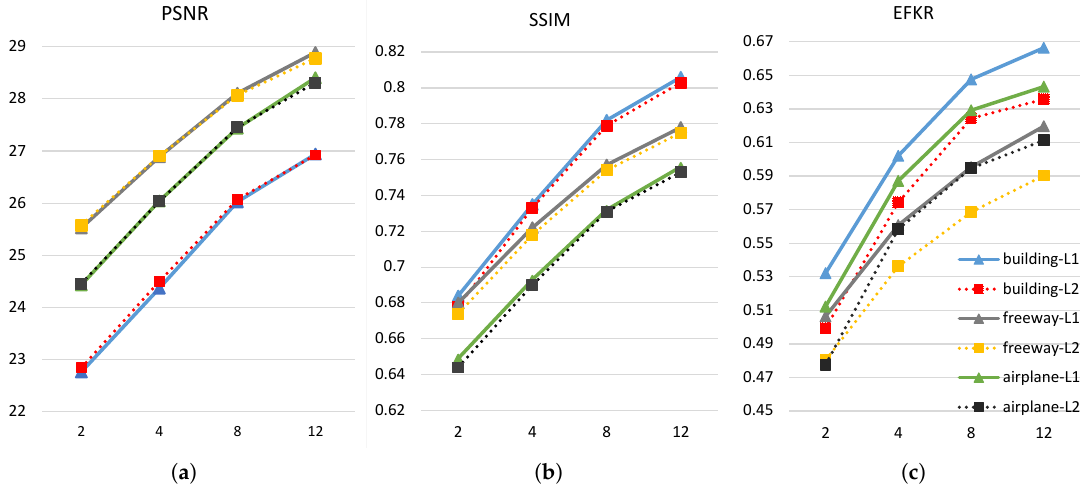
Figure 14. Evaluation index (PSNR, SSIM, and EFKR) values of MSR-net with L1 and L2